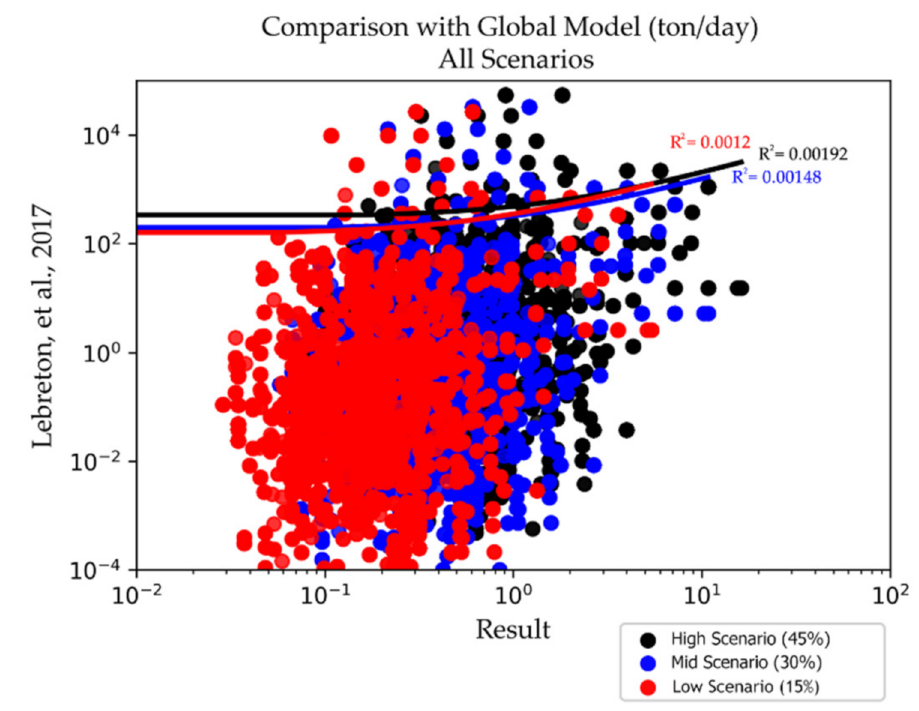
Figure 11. A comparison of Lebreton et al. [5] input data (2017) and Indonesia’s overall estuaries by scatter plot.